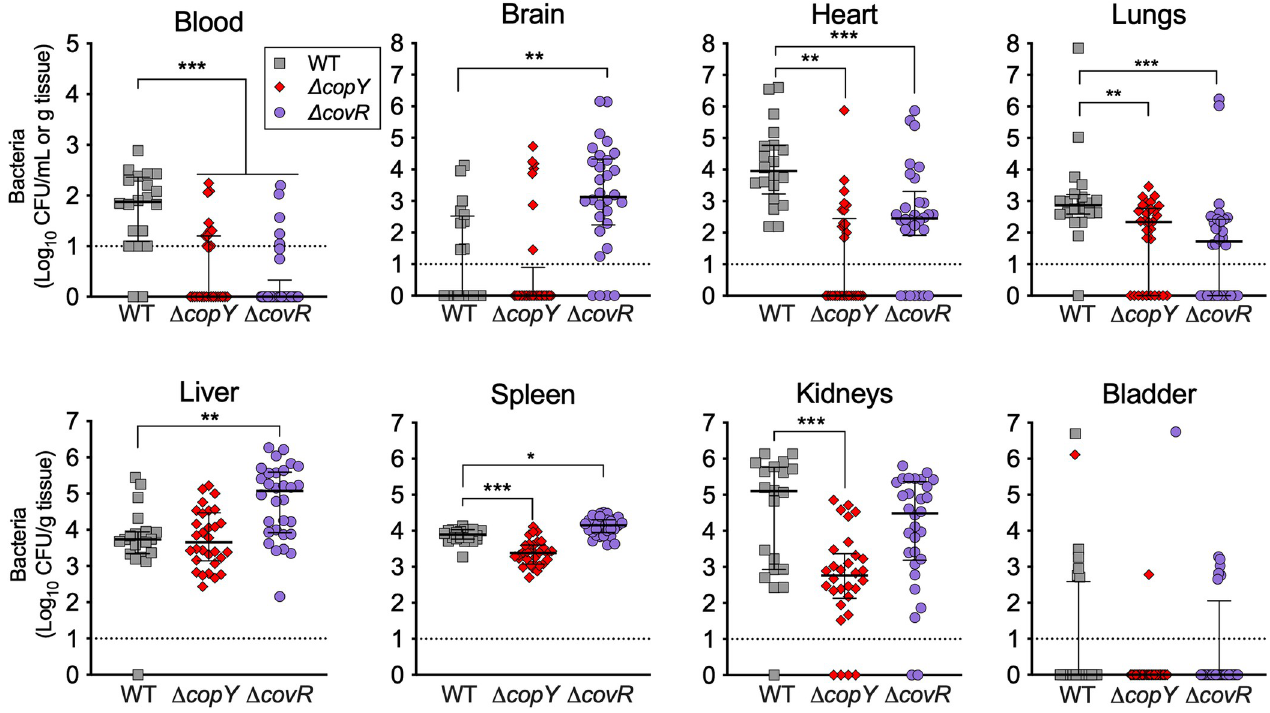
Fig 9. Mutations in copY and covR have major implications in colonization and disseminated spread of GBS bloodstream infection. Virulence of WT (grey squares), Δ copY (red diamonds) or Δ covR GBS (purple circles) in a mouse model of disseminated infection. C57BL/6 mice (6–8 weeks old) were intravenously injected with 10 7 bacteria; bacteremia and disseminated spread of bacteria to brain, heart, lungs, liver, spleen, kidneys and bladder were monitored at 24h post infection. CFU were enumerated and counts were normalized using tissue mass in g. Viable Cell counts of 0 CFU/mL were assigned a value of 1 to enable visualisation on log 10 y-axes. Lines and bars show median and interquartile ranges and data are pooled from 2–3 independent experiments each containing n = 10 mice; groups infected with mutants were compared to WT group using Kruskal-Wallis ANOVA with Dunn’s corrections for multiple comparisons ( � P < 0.05, �� P < 0.01, ��� P <